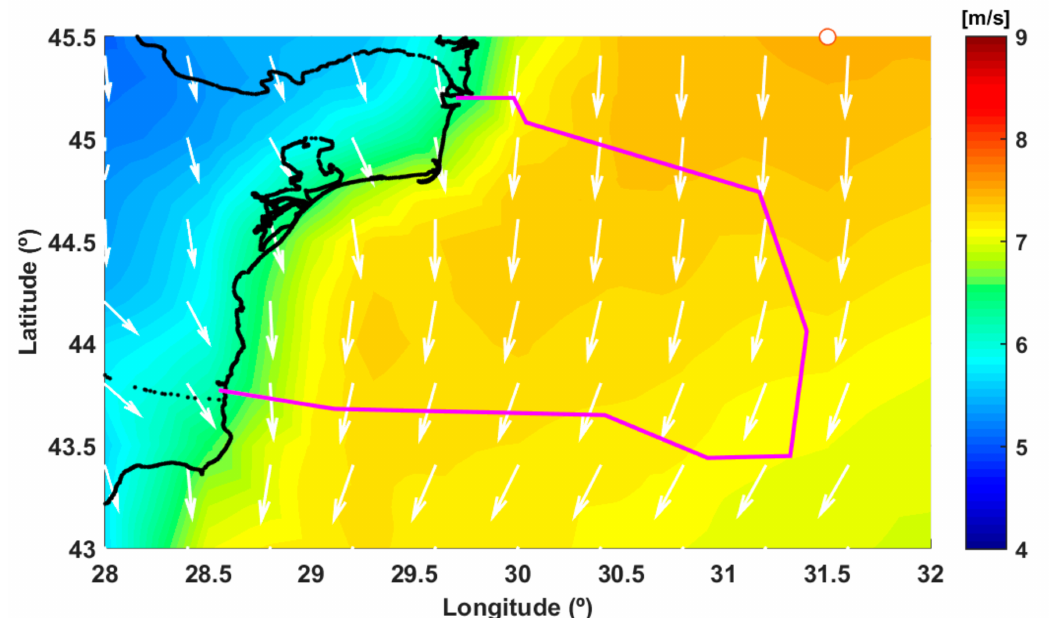
Figure 5. Average wind speed computed based on the ERA5 ( U 100 ) dataset for the Romanian coastal area over the time interval 2000–2019 (full-time distribution). The wind direction is represented by arrows, while the point defined by the highest wind speed is indicated with a white circle. The Romanian EEZ is indicated by the magenta